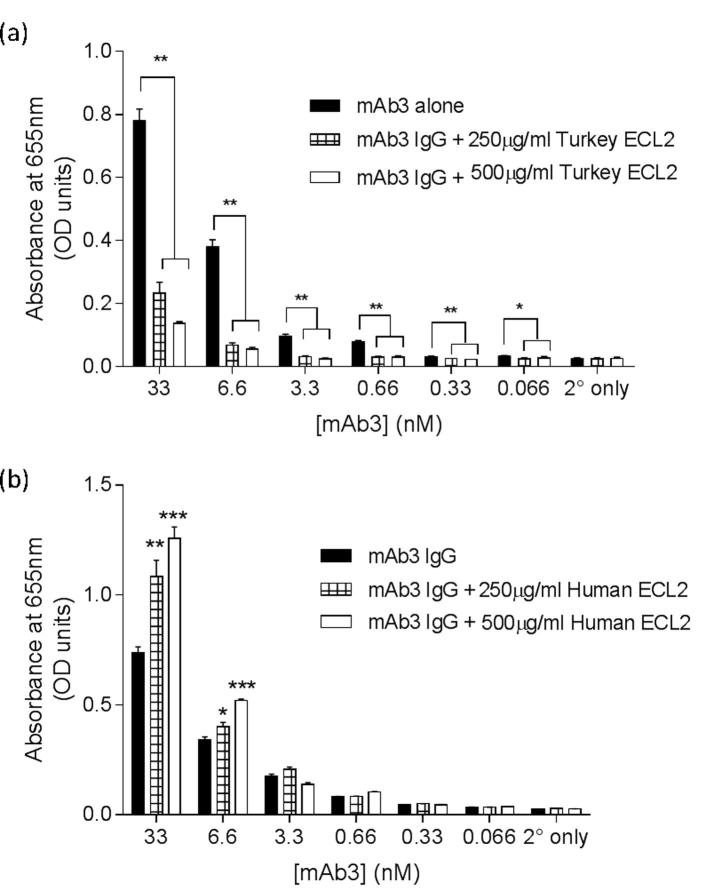
ELISA showing the effect of a (a) turkey or (b) human ECL2 peptide sequence (250 μg/ml or 500 μg/ml) on the binding of different concentrations of mAb3 to purified β1AR-m23 StaR. Included are controls for the secondary antibody alone, and the secondary antibody in combination with the relevant peptide. Bars are mean ± s.e.m. of triplicate determinations and these single experiments are representative of four separate experiments. *p < 0.05, **p < 0.01, ***p < 0.001, comparing binding of mAb3 at β1AR-m23 StaR to the other conditions, one-way ANOVA with Dunnett’s post hoc test.